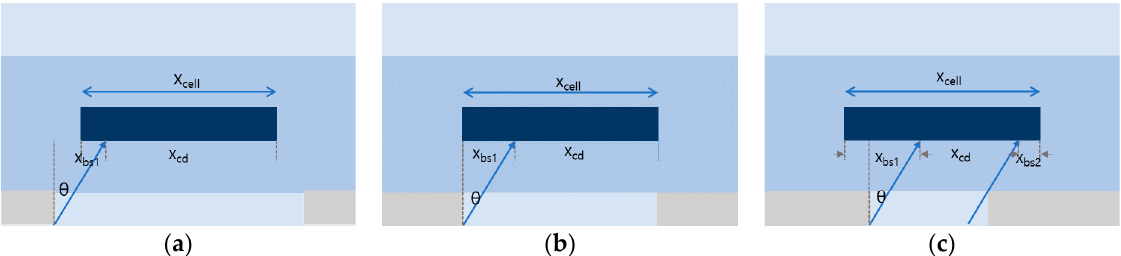
Figure 7. Shaded area depending on the width of the coated backsheet area: ( a ) smaller than cell distance; ( b ) identical to cell distance; ( c ) larger than cell distance.